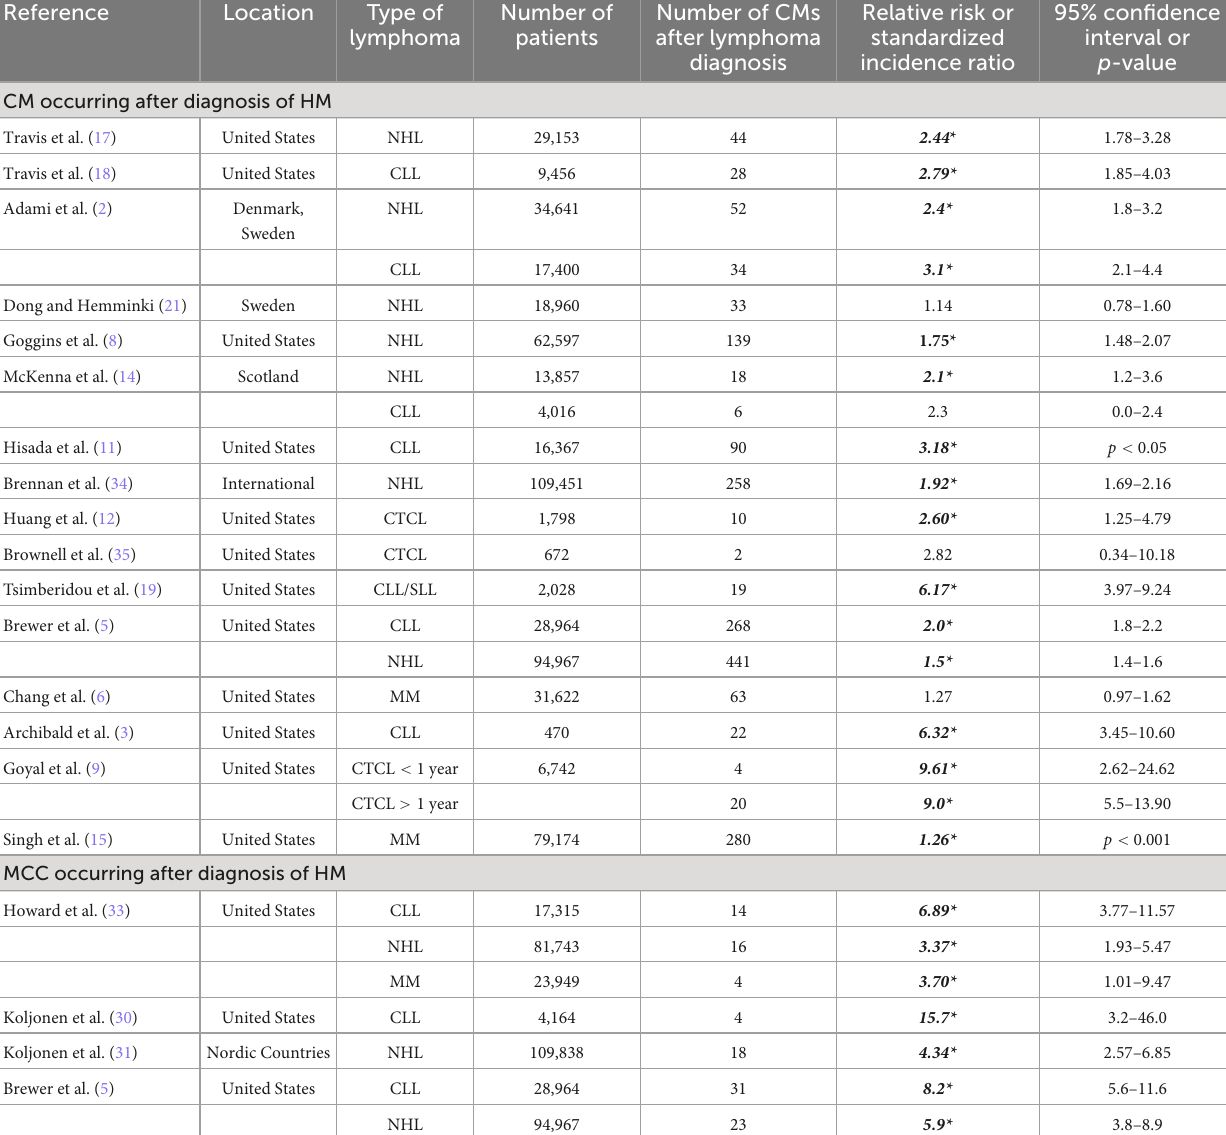
TABLE 1 Epidemiologic studies for CM and MCC as subsequent primary malignancy after HM (2, 3, 5, 6, 8, 9, 11, 12, 14, 15, 17–19, 21, 30, 31, 33–35).